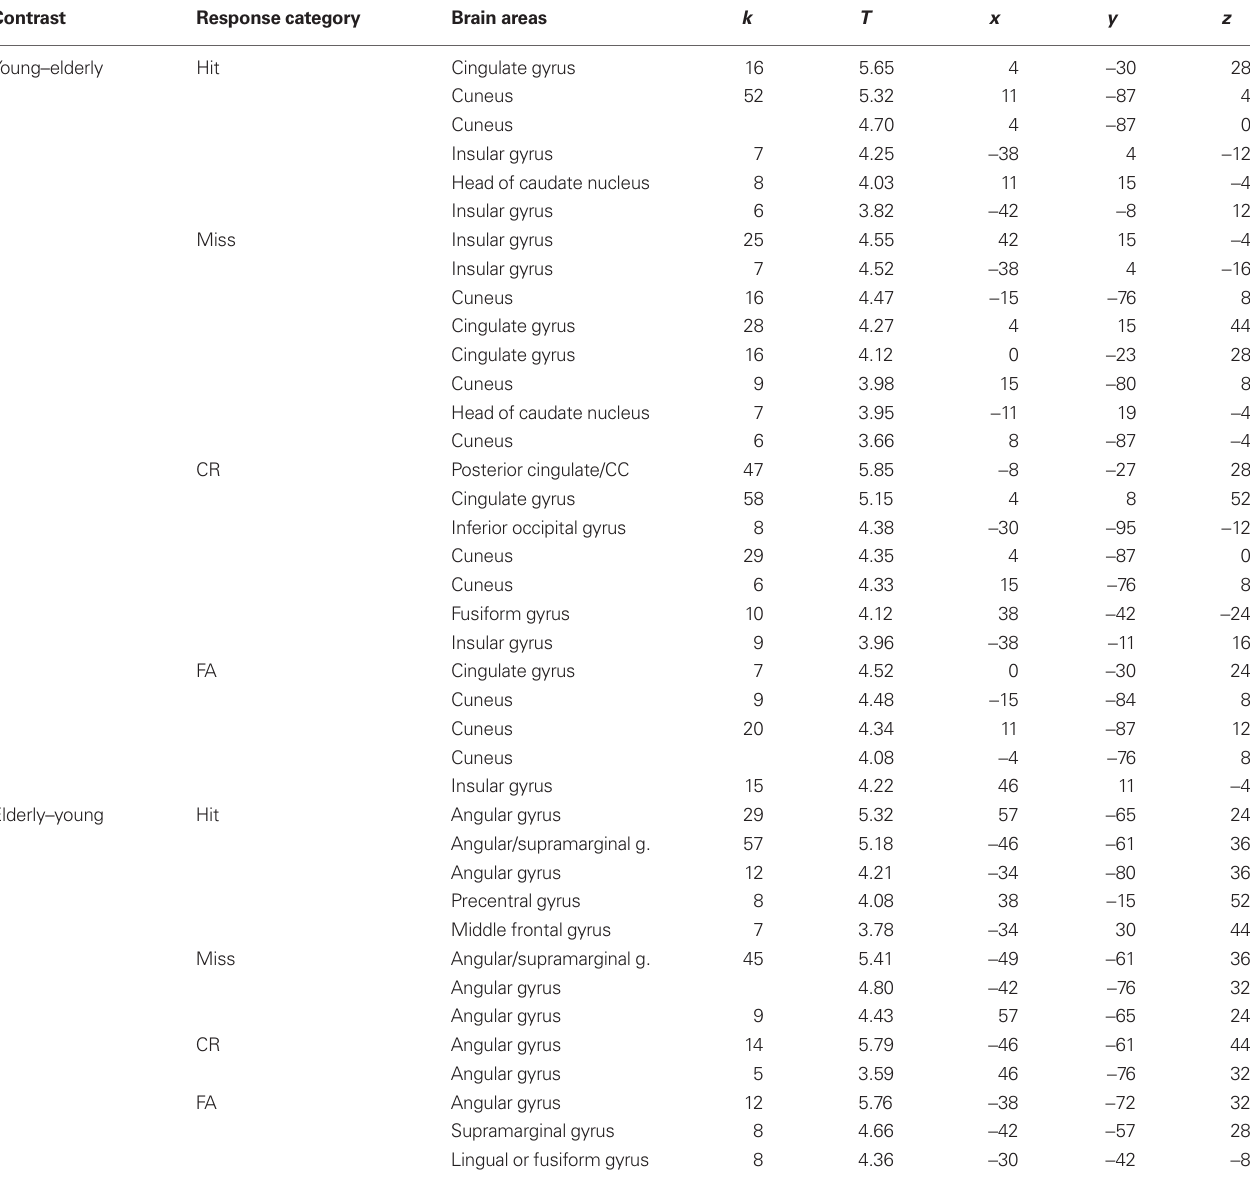
Table 4 | Differences of activation between the young and elderly for Hit, Miss, false alarm (FA), and correct rejection (CR). Contrast Response category Brain